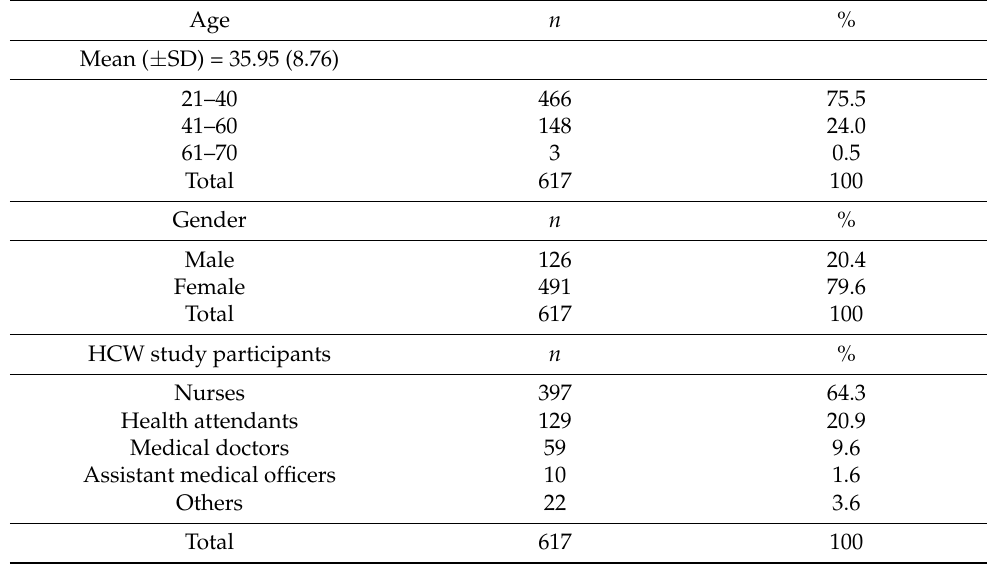
Table 1. Sociodemographic data for the enrolled HCWs of USM Health Campus.